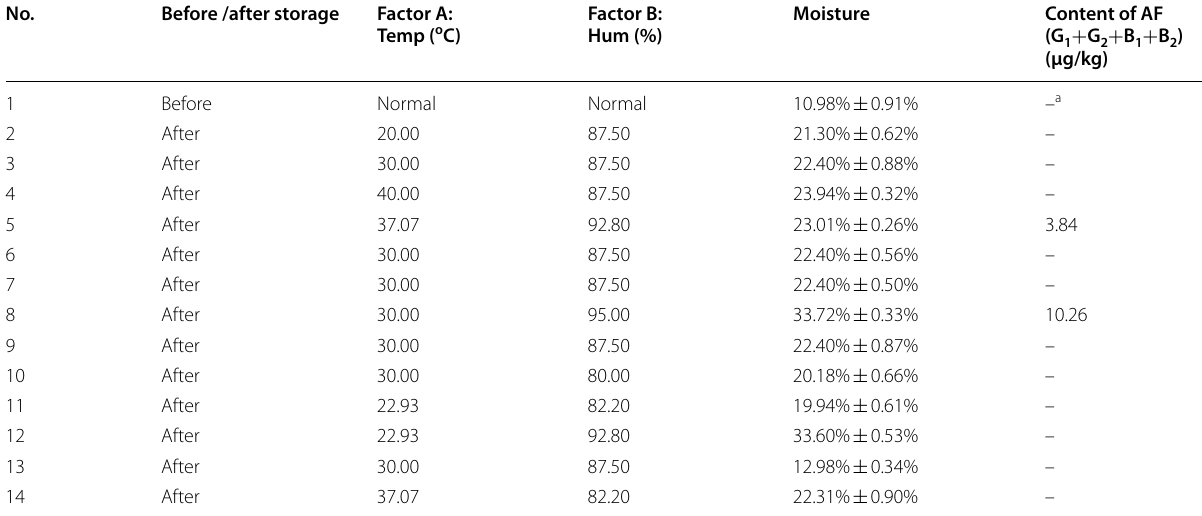
Table 2 Contents of moisture and AF(G temperature and humidity conditions